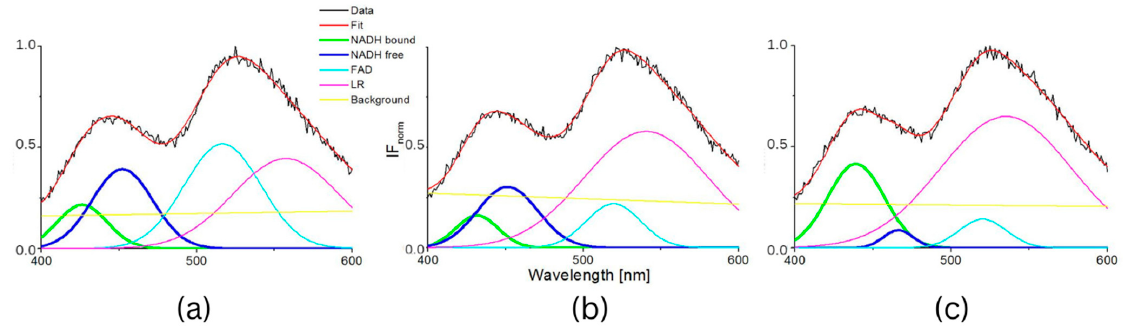
Figure 6. Intensity of normalized fluorescence spectra of suspensions of mixtures of 3T3 cells and CT26 cells ( a ) 4 % CT26 ( b ) 13 % CT26 ( c ) 27 % CT26.